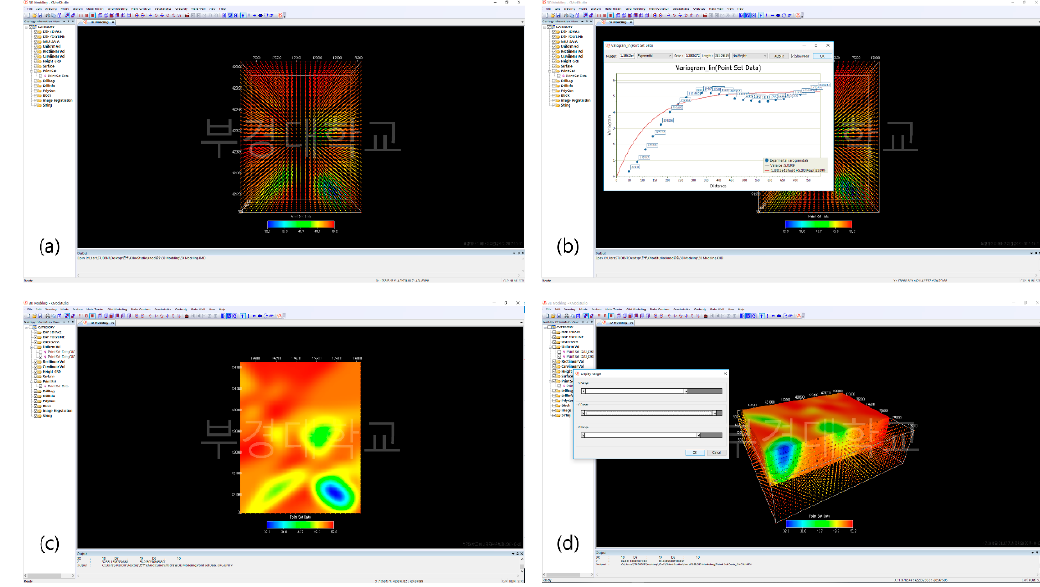
Figure 2. Major unit operations for orebody modeling using KmodStudio. ( a ) Three-dimensional (3D) visualization of sampling data representing the grade of an orebody; ( b ) variogram modeling; ( c ) spatial interpolation using ordinary Kriging; and ( d ) 3D visualization and evaluation of the estimated grade of the orebody.